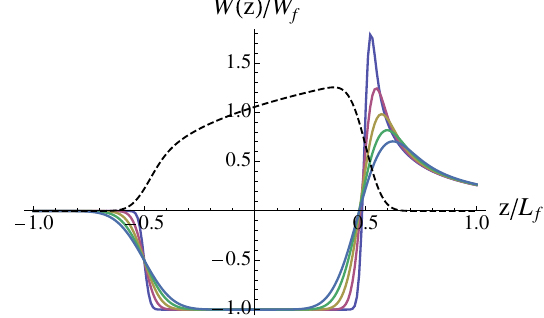
FIG. 5. (Solid) The 1D CSR wakefield that would be generated by the bunches of Fig. 4, shown for the values 8%, and 10%, demonstrating the effect of nonzero initial energy and transverse emittance (cid:4) spread (cid:2) (cid:12) 0 CSR wakefield. (Dashed) The current profile ð L ^ D ¼ 6% is shown for comparison, illustrating that particles case near the head of the bunch at z=L CSR-induced energy